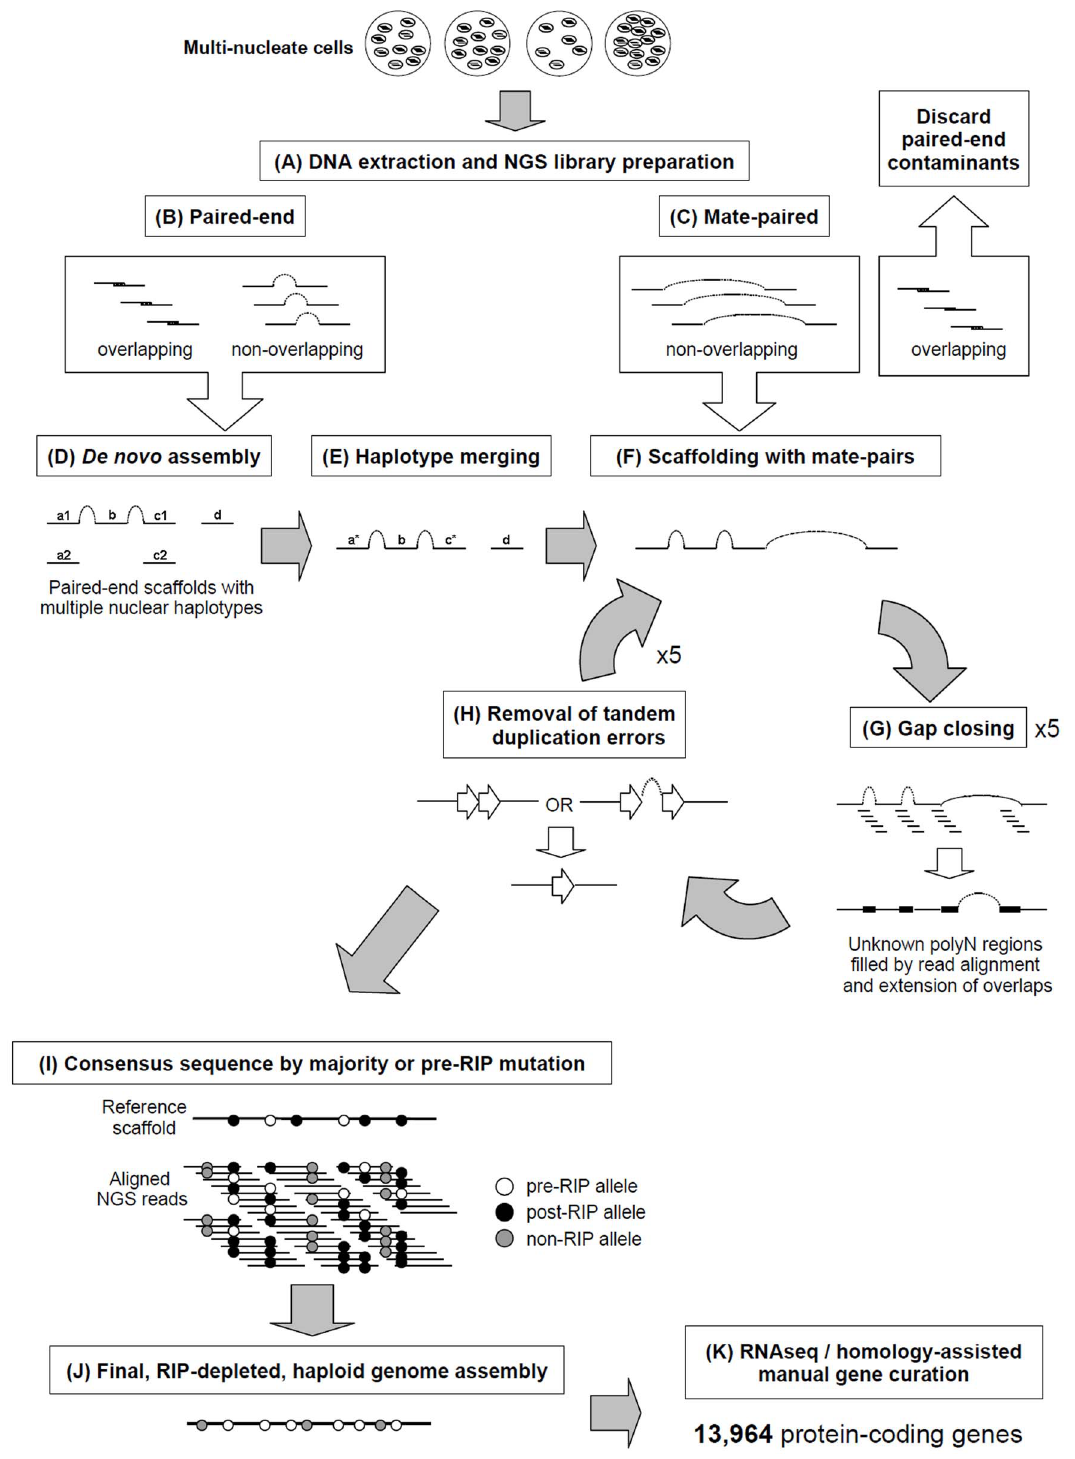
Figure 1. A novel pipeline was employed to assemble the multinucleate, heterozygous genome of Rhizoctoniasolani AG8. A) Genomic DNA from multinucleate cells with variable nucleic copy numbers was prepared for next-generation sequencing (NGS) Illumina paired-end (B) and mate-paired (C) short-read libraries. The 3 9 ends of read pairs from both (B) and (C) were tested for overlapping sequence, indicating short DNA fragment sizes. Overlapping pairs in mate-paired libraries (C) were discarded as these indicated paired-end contaminants which would lead to assembly errors. D) De novo assembly was performed combining the non-overlapping and overlapping paired-end read pairs that were merged into longer single-end reads. E) Redundant haplotypes where equivalent regions of the genome from multiple nuclei were present more than once in the assembly were merged into a single haplotype sequence. F) Non-overlapping mate-paired reads were used to build assembled sequences into larger scaffold sequences. Stretches of unknown bases (polyN) in the assembly were filled where possible (G) by alignment of genomic NGS reads to the